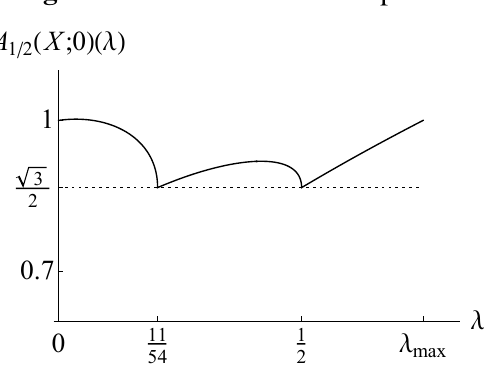
Figure 2. Illustration of Example